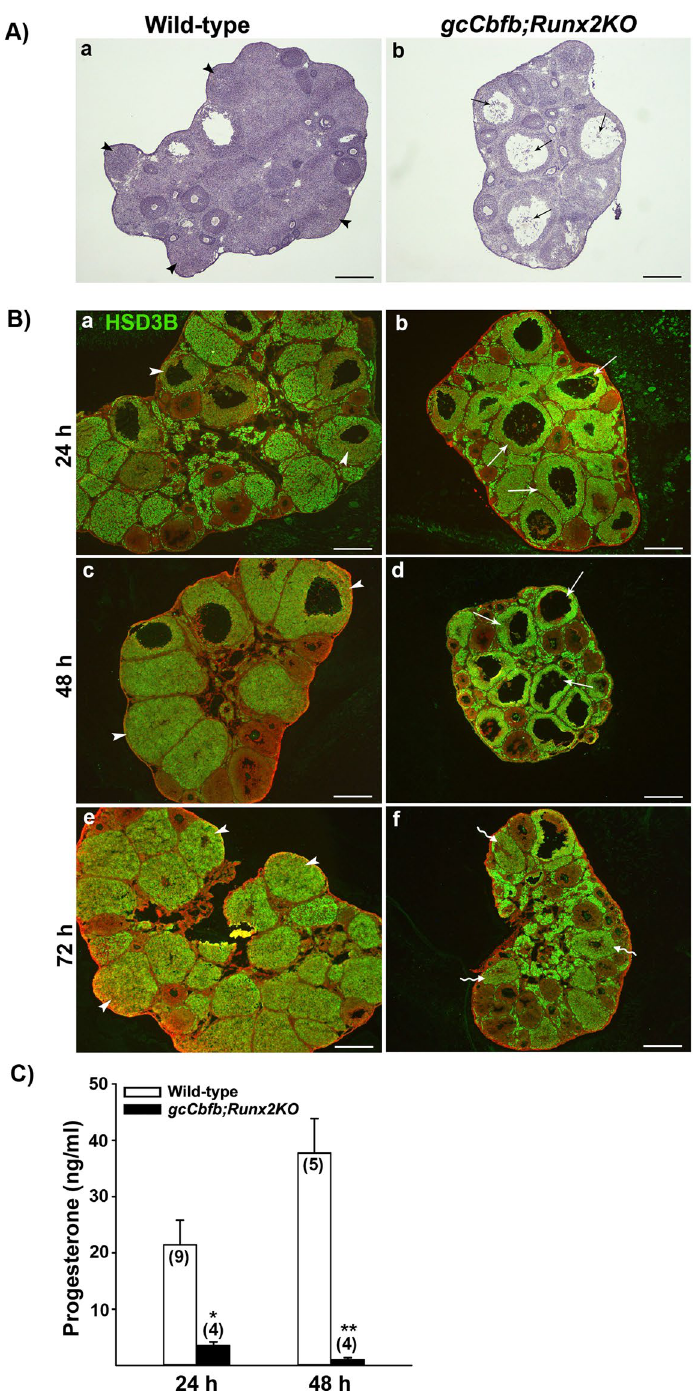
Figure 6. Assessment of ovarian morphology during the post-ovulatory period in gcCbfb;Runx2KO mice. ( A ) Ovarian sections obtained at 24 h post-hCG were stained with hematoxylin (n = 3 animals/ genotype). ( B ) Ovarian sections obtained at 24, 48, and 72 h post-hCG were immunostained for HSD3B to easily locate corpora lutea and unruptured follicles (n = 3 animals/genotype). HSD3B was detected as green fluorescent staining, and ovarian sections were counterstained with propidium iodide (red). Arrowheads, arrows, and wavy arrows point to corpora lutea, unruptured follicles, and collapsed luteinized follicles, respectively. Scale bars, 500 μ m for all the images. ( C ) The levels of serum progesterone were measured in blood samples collected at 24 and 48 h after hCG administration. The number inside each bar represents the number of mice evaluated. * p = 0.024, ** p =